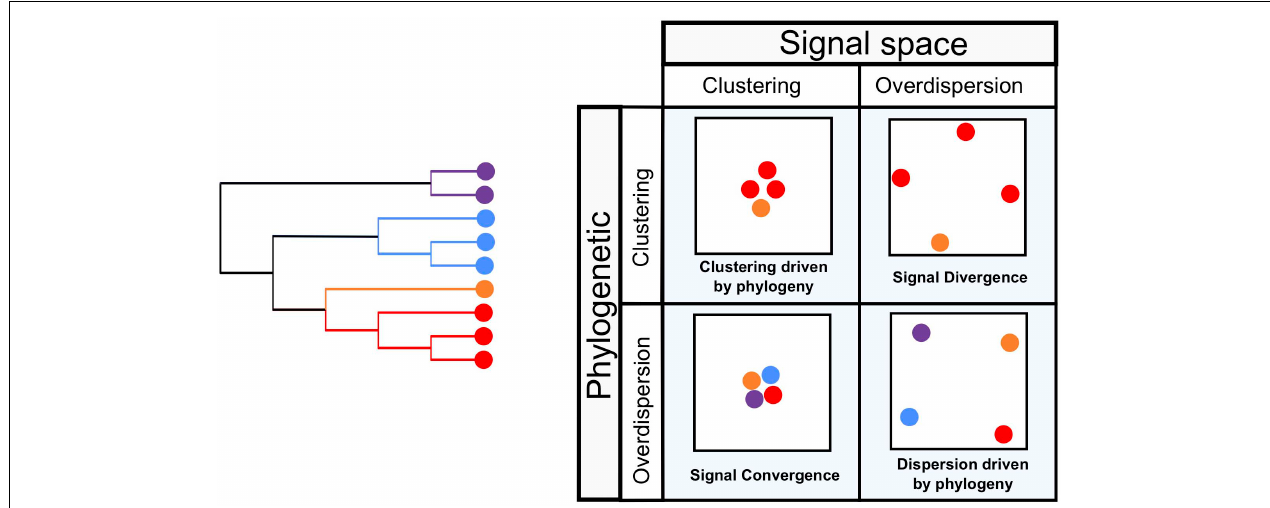
FIGURE 2 | Community phylogenetic analyses and signal space. Phylogenetic information is an important component in our understanding of acoustic community assembly and structure. In a hypothetical, simplified series of communities drawn from the phylogeny on the left [inspired by the principles of community phylogenetics (Webb, 2000; Cavender-Bares et al., 2004)], phylogenetic overdispersion or clustering combined with similar patterns in signal space suggest that phylogenetic relationships drive acoustic community structure (top left and bottom right squares), whereas other patterns may be driven by signal partitioning or convergence, among other processes (top right and bottom